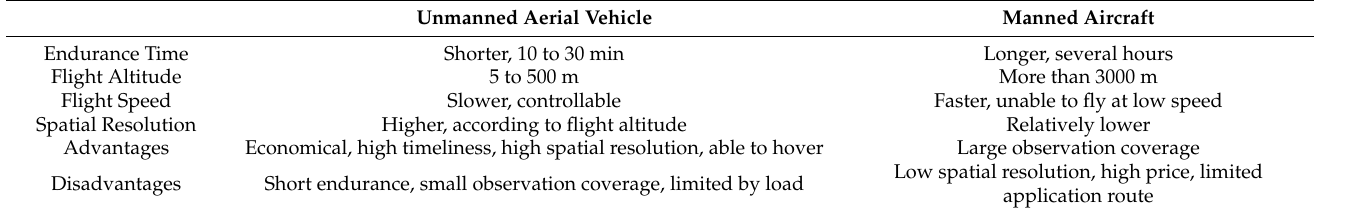
Table 1. Comparison of UAV and manned aircraft platform features.